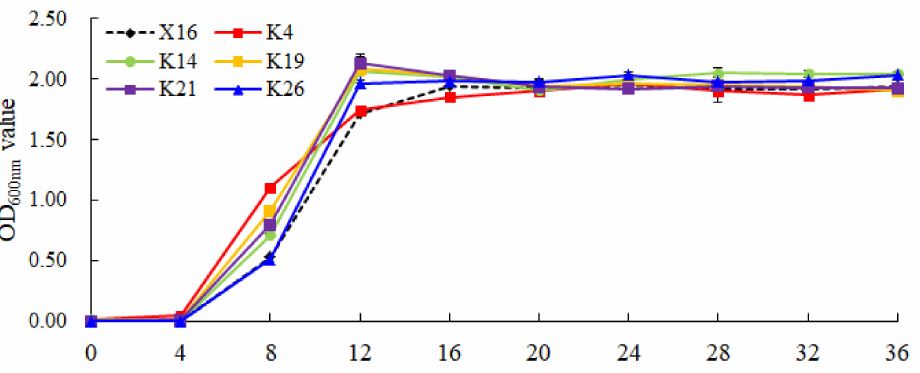
Figure 3. Growth curve of the selected yeasts isolated from